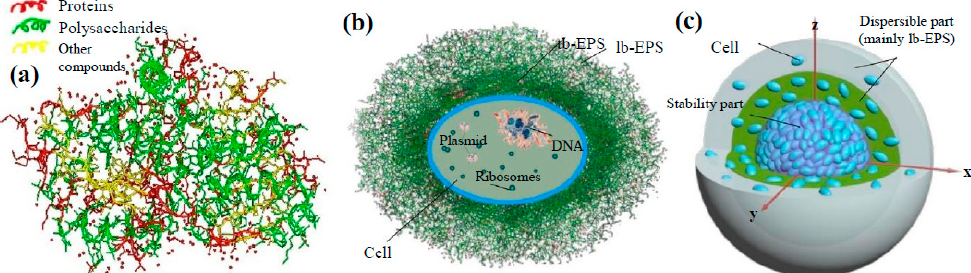
Figure 3. Schematic of: ( a ) EPS structure, ( b ) cell structure and ( c ) bio-floc structure [3].